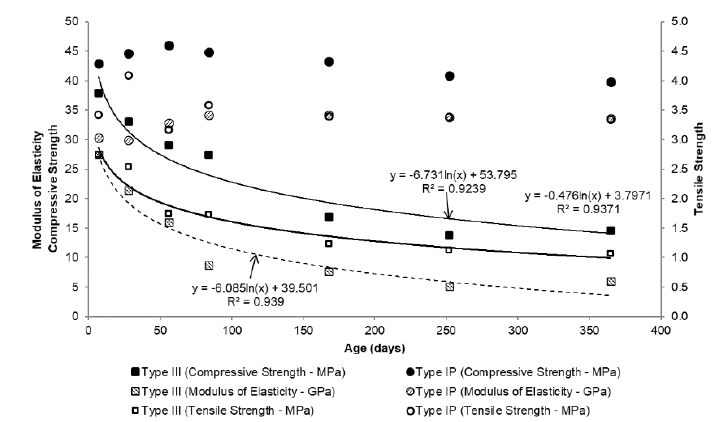
Figure 8. Evolution of mechanical properties over